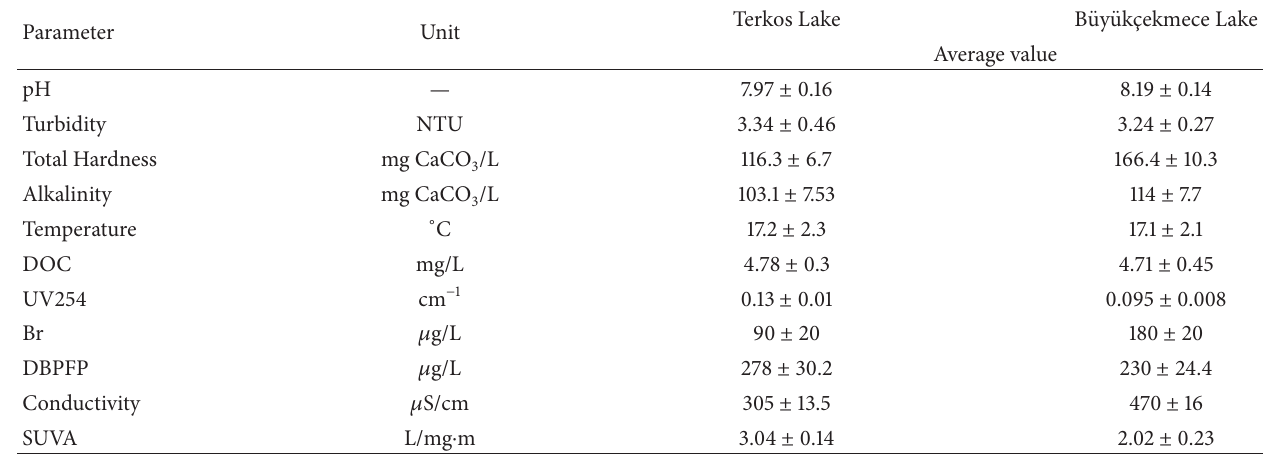
Table 1: Raw water quality parameters.